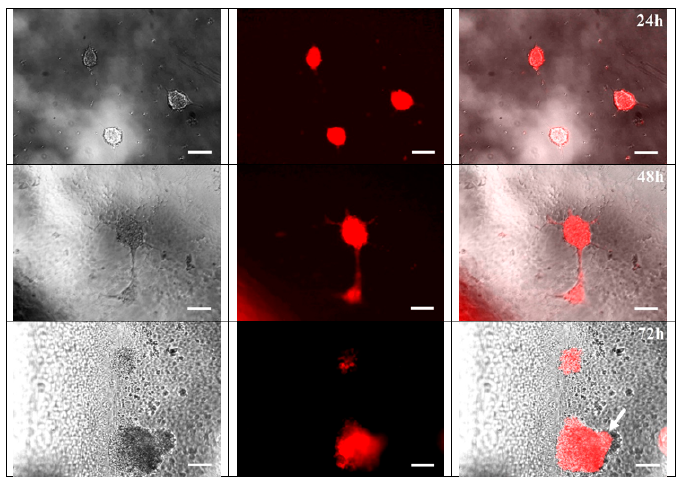
Figure 11. Images of neural crest stem cells (bNCSC), expressing red fluorescence signal (RFP) after 24 h, 48 h, 72 h of culture on PVDF substrate (×20); arrow indicates cells migrating from the neurosphere. Scale bar is 25 μ m.